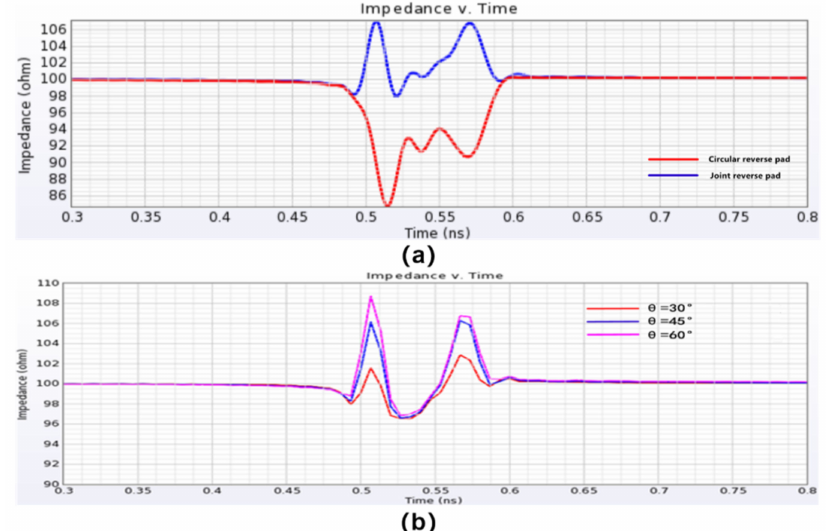
Figure 12. ( a ) Comparison of circular reverse pad (red line) and joint reverse pad (blue line, the best parameters are not used); ( b ) insertion loss of strip coplanar waveguide with optimized vias’ relevant